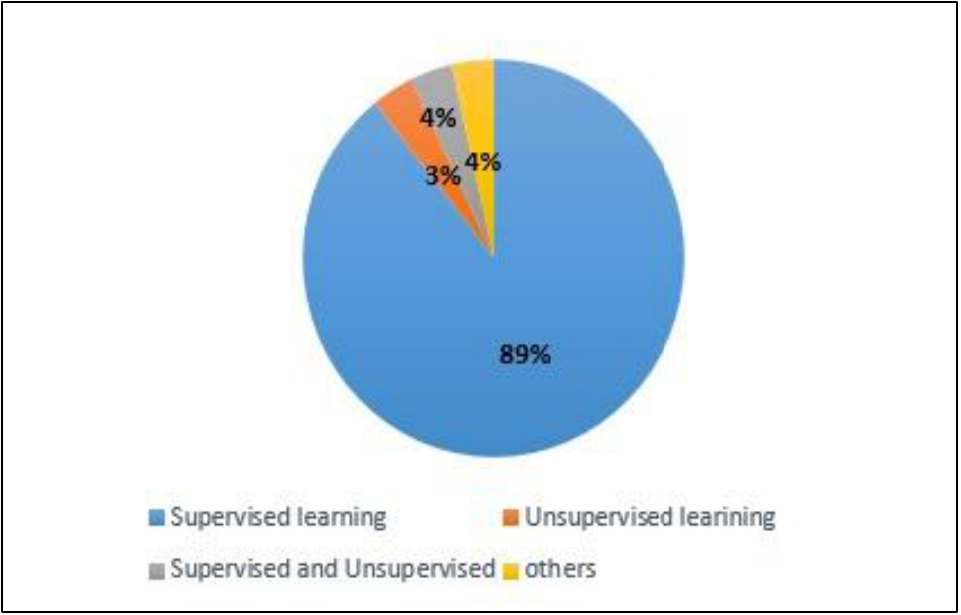
Figure 2. Percentage of the mchine learning and deep learning techniques used idetecting SQL injection attacks.